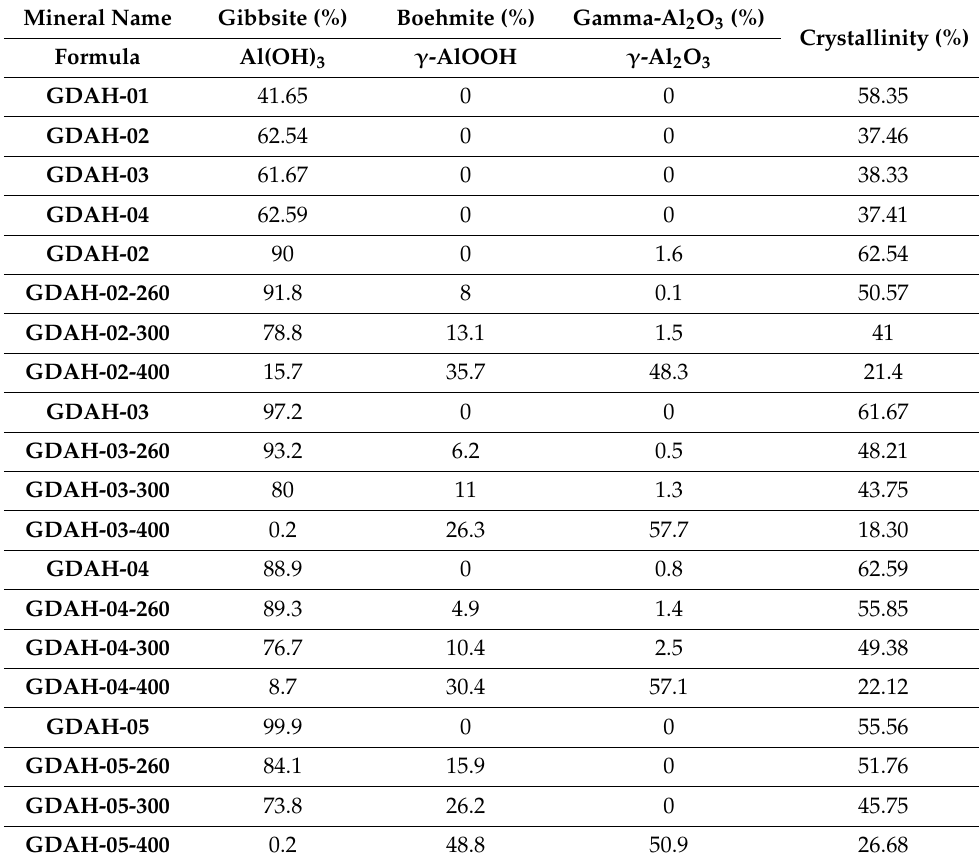
Table 2. Effect of the calcination temperature on the phase composition and